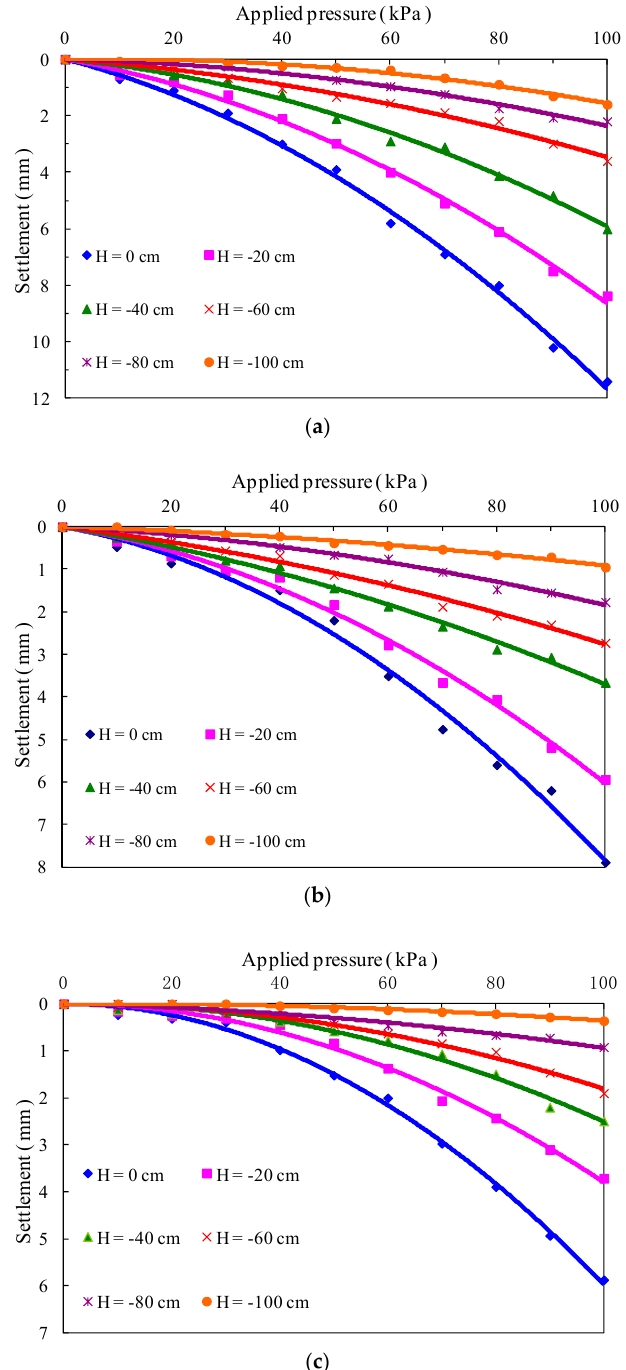
Figure 5. Applied pressure-settlement curves for unreinforced and reinforced subgrade models. ( a ) Unreinforced subgrade model; ( b ) fiber-reinforced subgrade model; ( c ) fiber-cement-reinforced subgrade